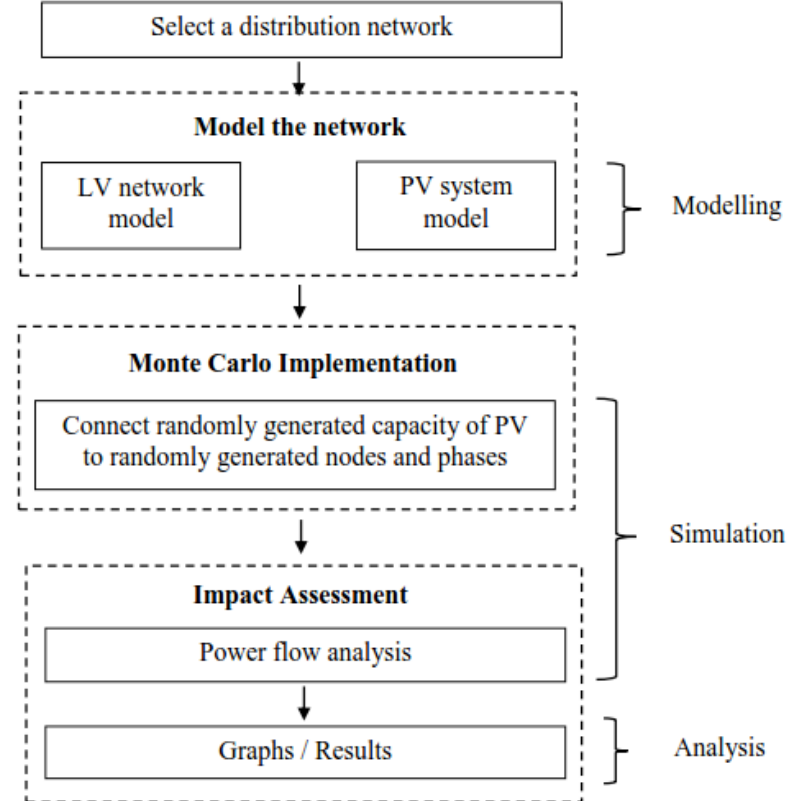
Figure 1: Methodology of the